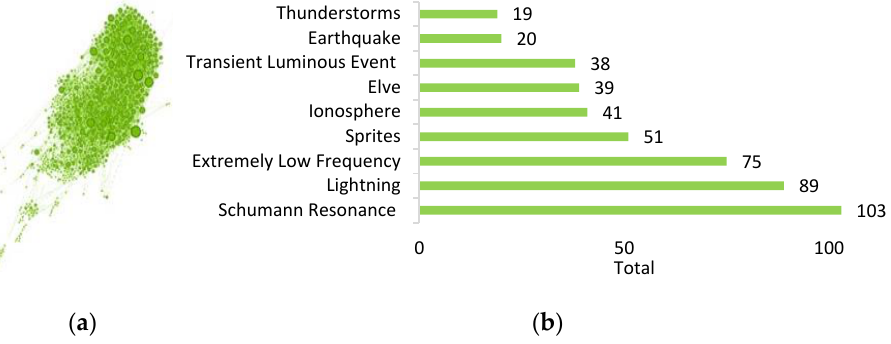
Figure 8. Representation of the lightning ELF phenomena community: ( a ) publications, ( b ) keywords.